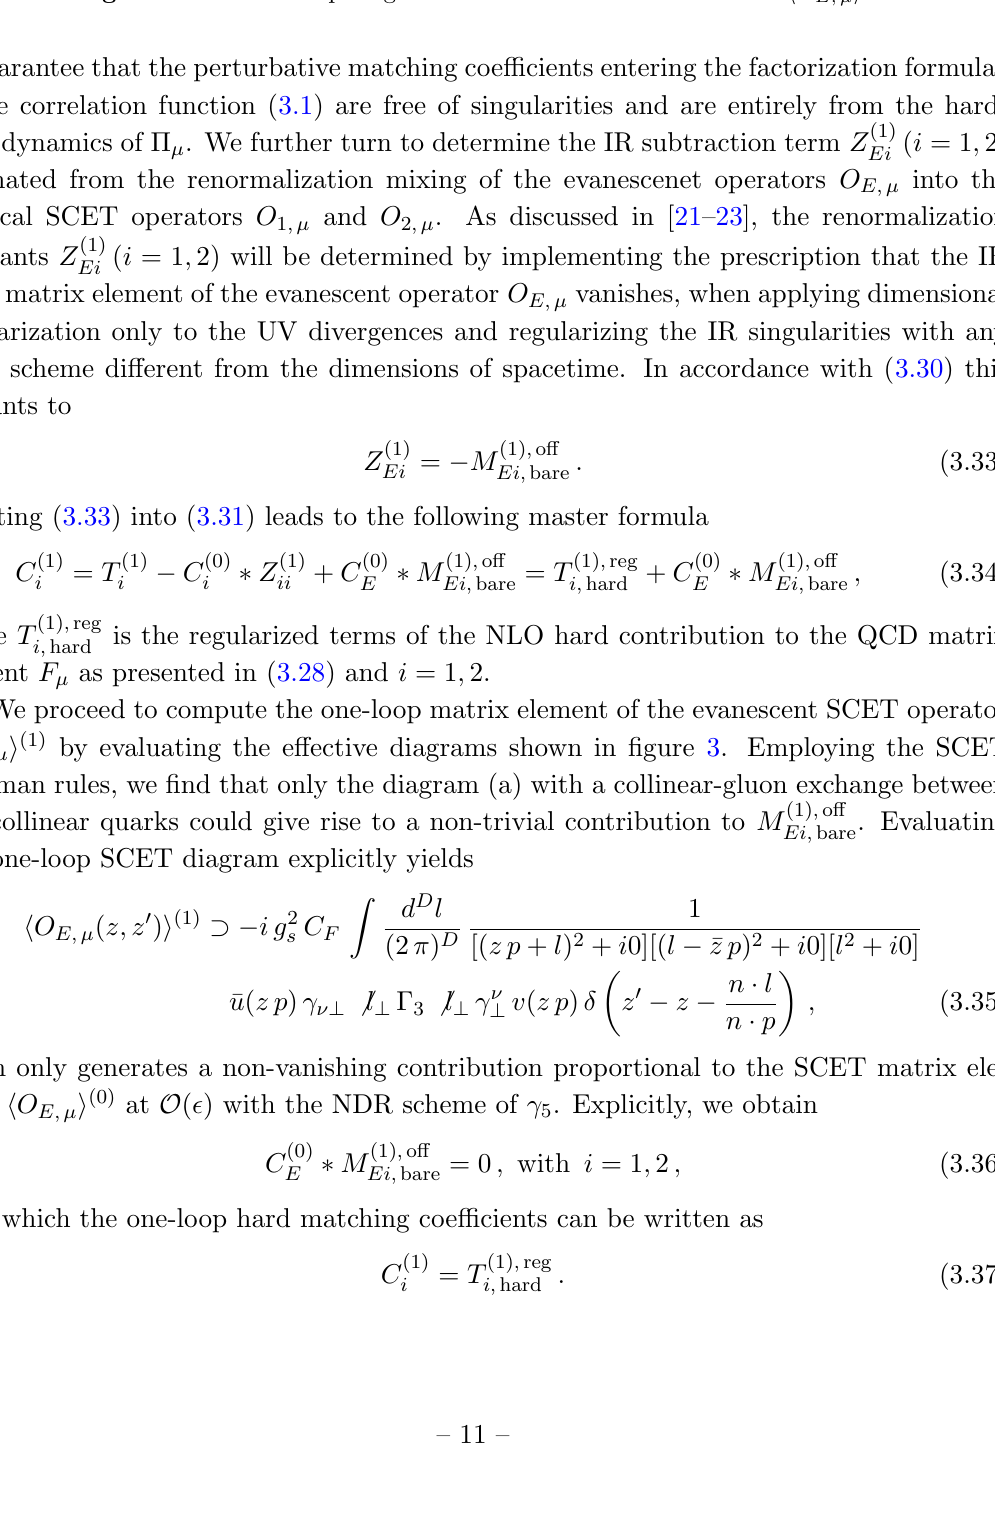
Figure 3 . The one-loop diagrams for the SCET matrix element h O E;(cid:22) i